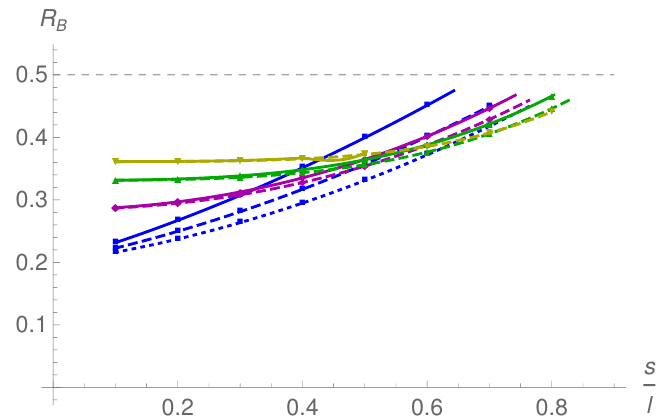
Figure 14 . Demonstration of weak monogamy in the S C phase in the ( d + 1) -dimensional AdS soliton background as a function of s/l for various d and total widths L = 3 l + 2 s . Notation of curves as in figure